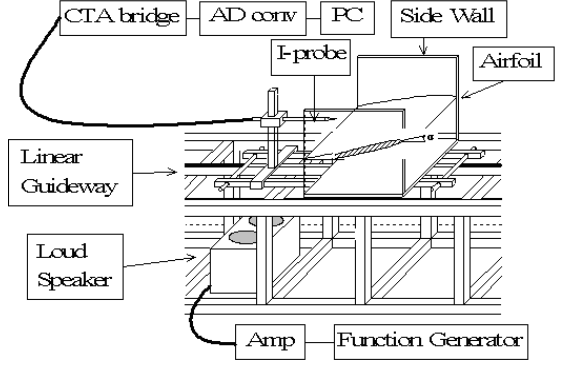
Fig. 1 Over view of experimental